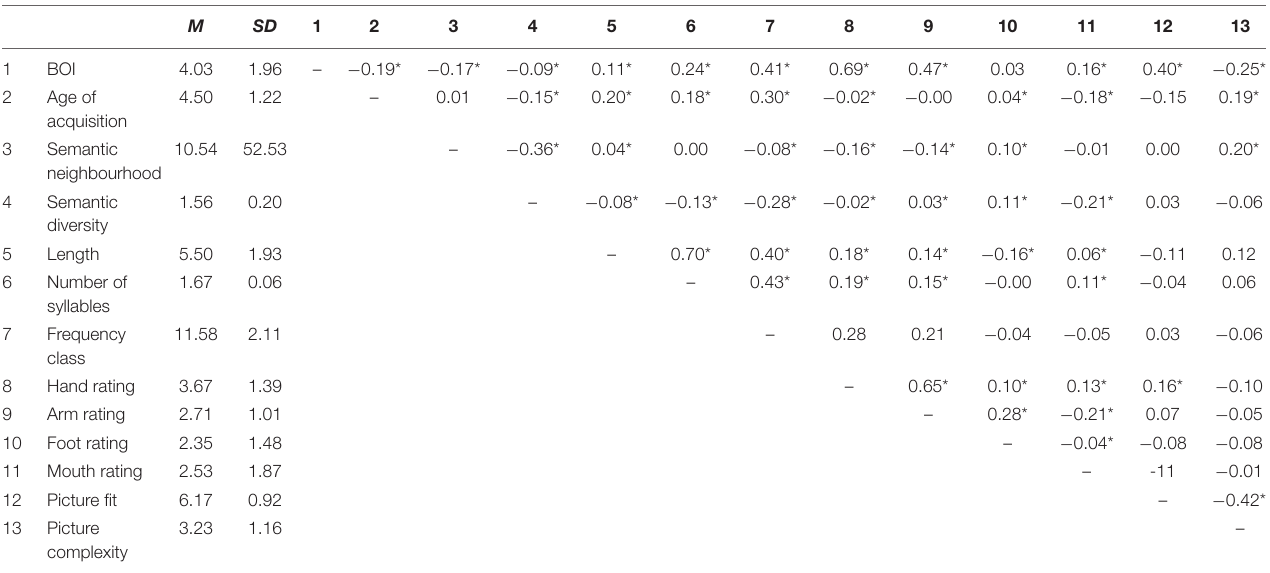
TABLE 1 | Means, standard deviations, and correlation coefficients for scores on the word ratings (BOI and body-part ratings), picture features (complexity and fit) and word variables (semantic neighbourhood, semantic diversity, length, number of syllables, frequency